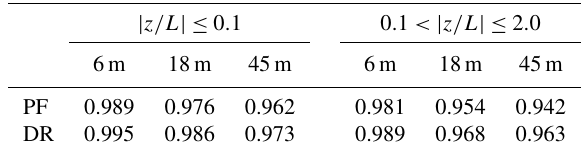
Table A1. Correlation coefficients between u ∗ R and u ∗ using the planar fit (PF) or double rotation (DR).